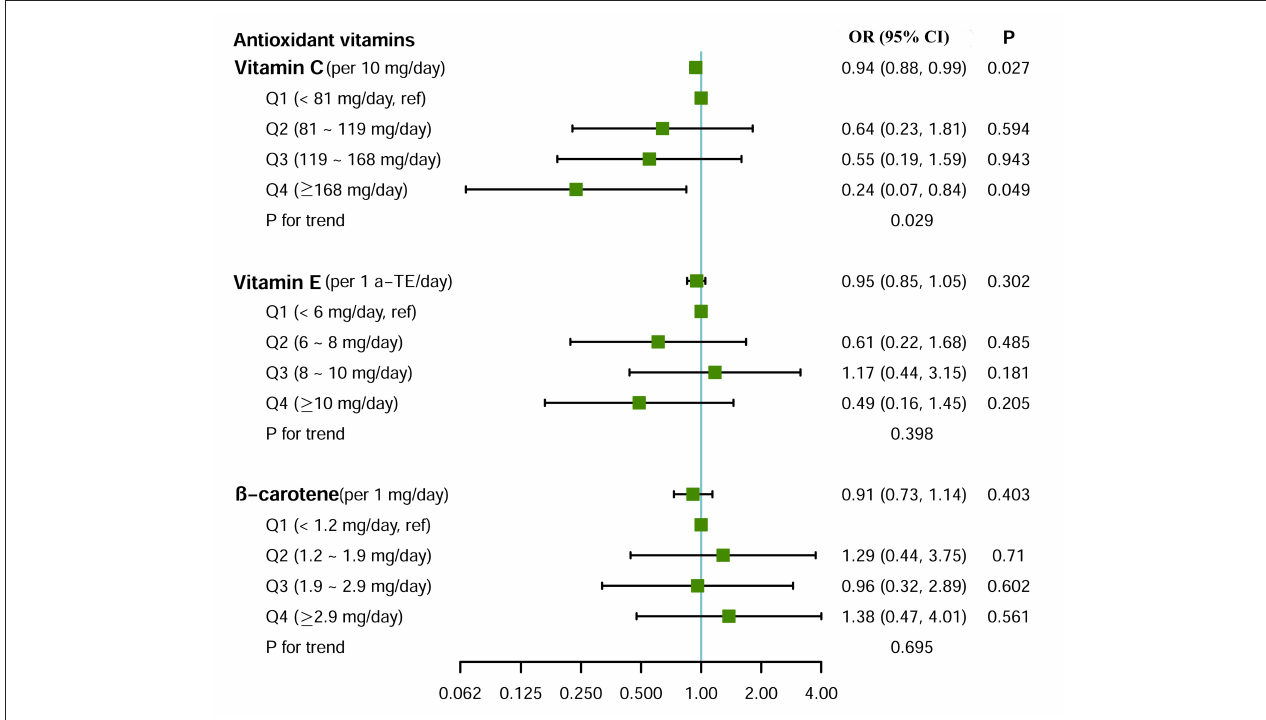
FIGURE 2 | Effect of dietary intake of antioxidant vitamins on small airway dysfunction. Logistic regression model adjusted for age, sex, body mass index, education level, family income level, smoking status, packyears, and drinking status. For the test of trend, we calculated the association with small airway dysfunction by treating the categories of antioxidant vitamin as ordinal